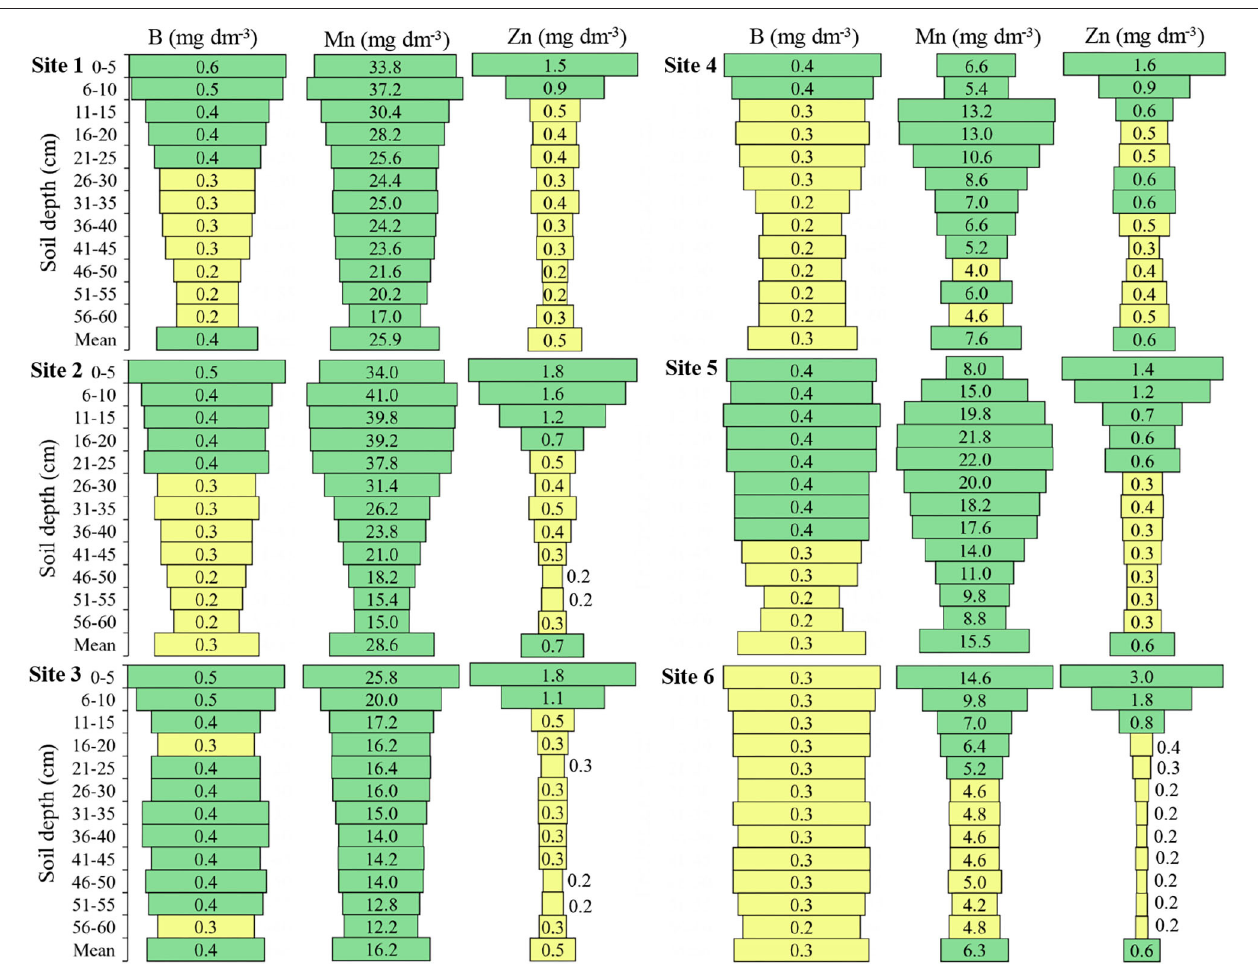
FIGURE 4 | Boron (B), manganese (Mn), and Zinc (Zn) in the six locations and at different soil depths. Green color: adequate values (B ≥ 0.4; Mn ≥ 6.0; Zn ≥ 0.6) Yellow color: intermediate values (B 0.2–0.3; Mn 2.5–5.0; Zn ≥ 0.2–0.5); Red color: inadequate values (B ≤ 0.1; Mn ≤ 2.4; Zn ≤ 0.1) to soils of South of Brazil (CQFS, 2016